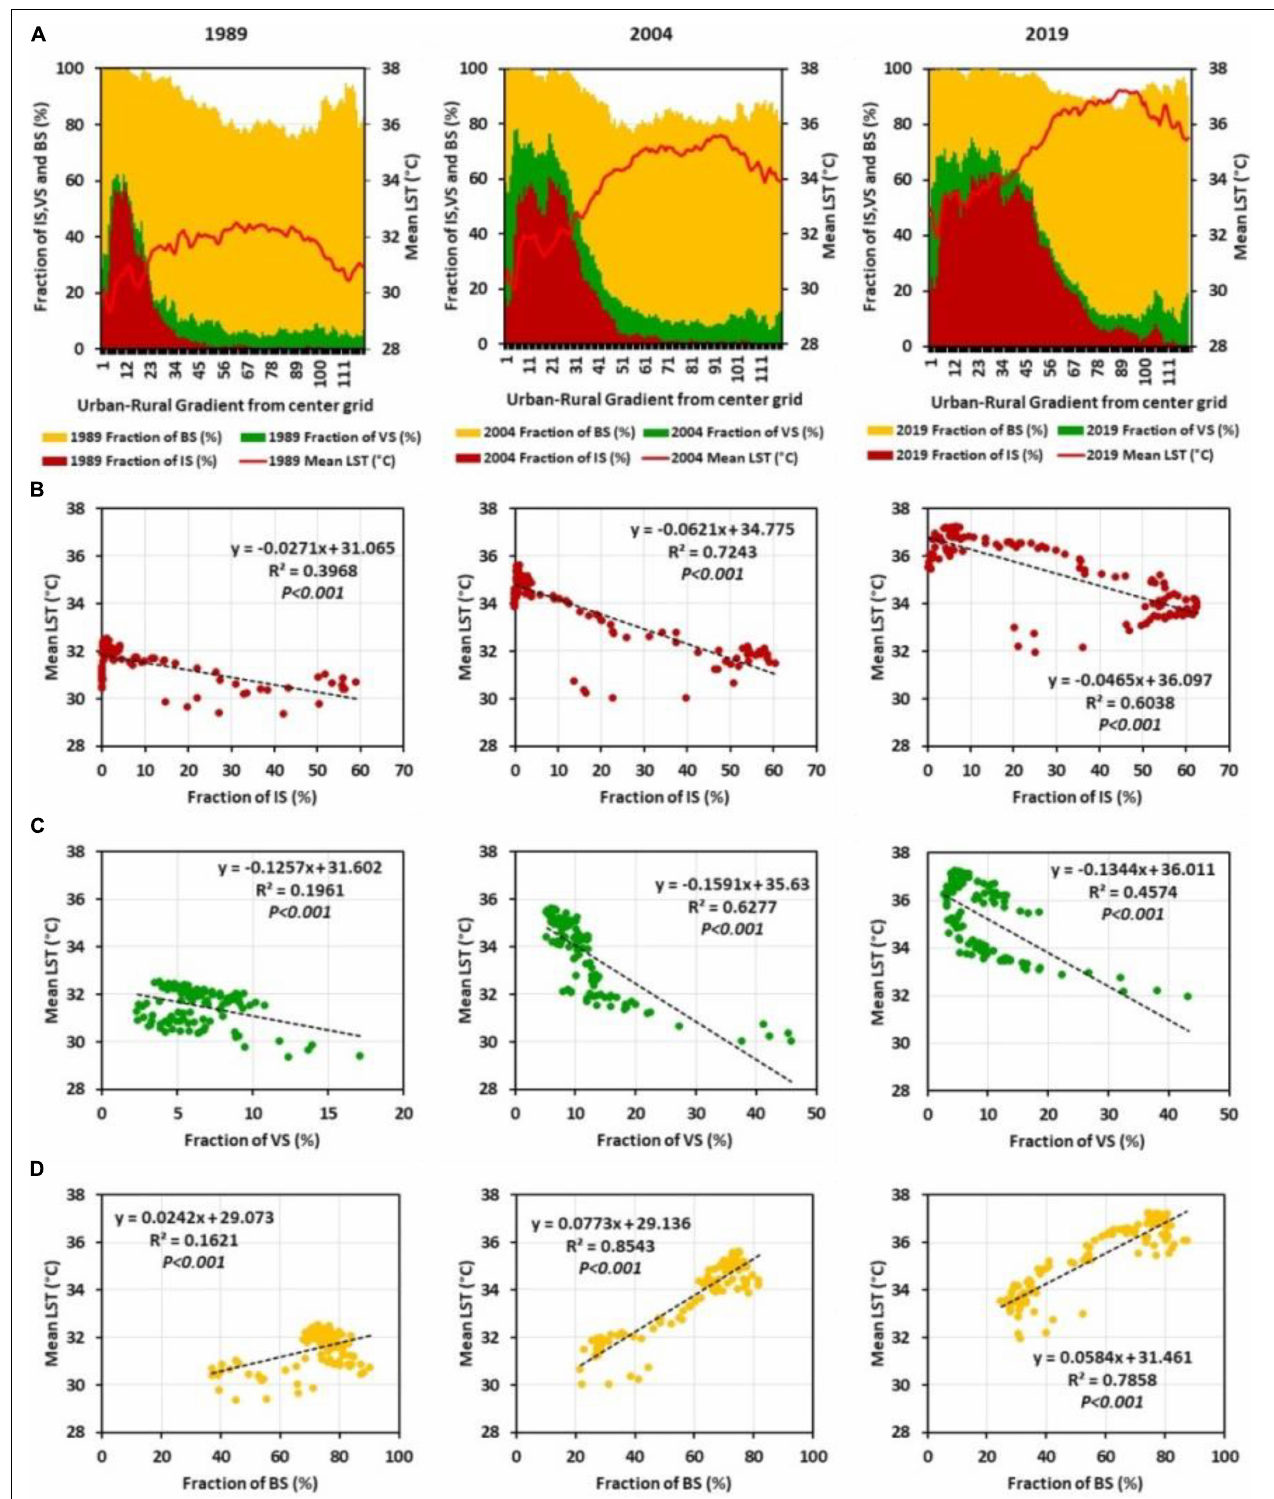
FIGURE 4 | (A) Spatial pattern of MLST, FIS, FVS, and FBS along the URG for 1989, 2004, and 2019; (B) scatter plots between MLST and FIS, (C) scatter plots between MLST and FVS, and (D) scatter plots between MLST and FBS.